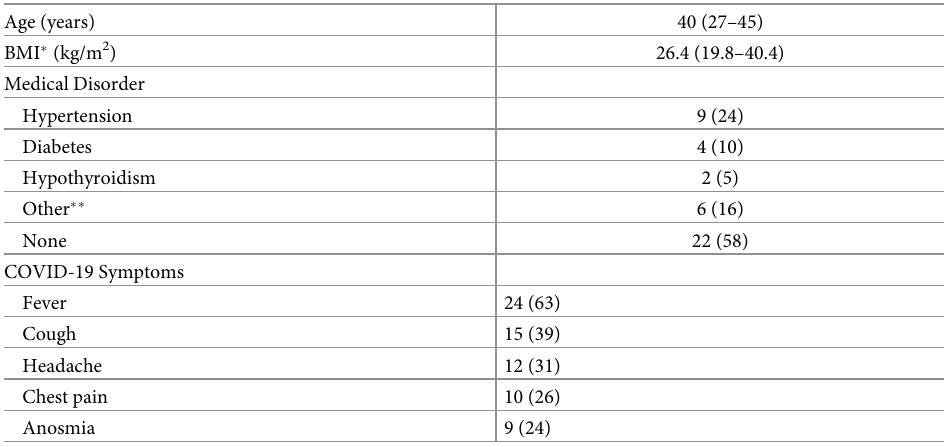
Table 1. Characteristics and symptoms of the patients (n =